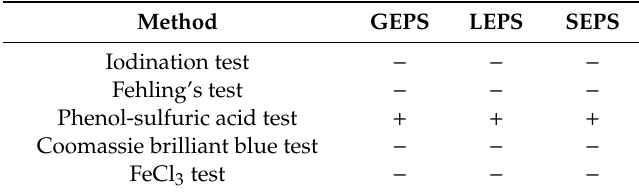
Table 1. Comparison of physicochemical properties of